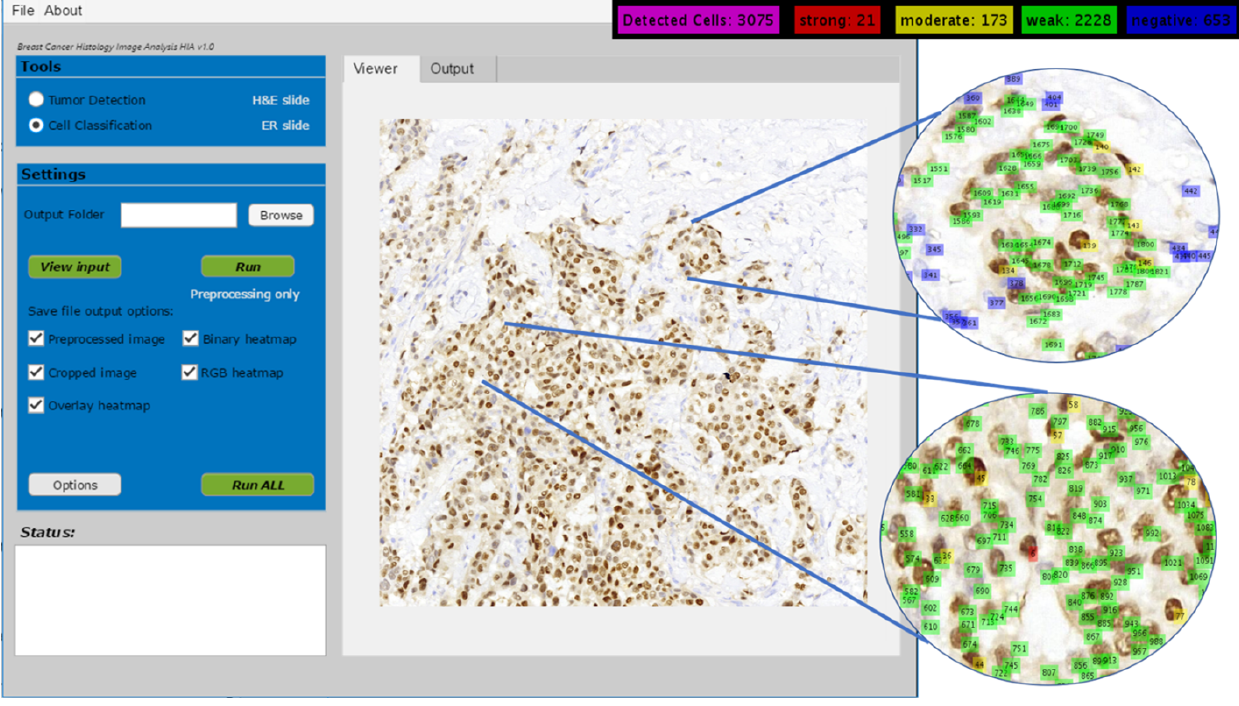
Figure 9. Cell detection and classification in ER-IHC breast carcinoma assessment